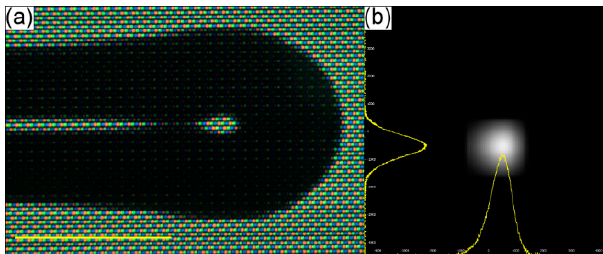
Figure 3. ( a ) Picture of the microlensed tip (MFT) of the MMF coupler output arm. ( b ) Far field beam profile of the MFT output beam. The profiles in the X and Y directions are both Gaussian-like. Scale bar in 3a is 125 µm.